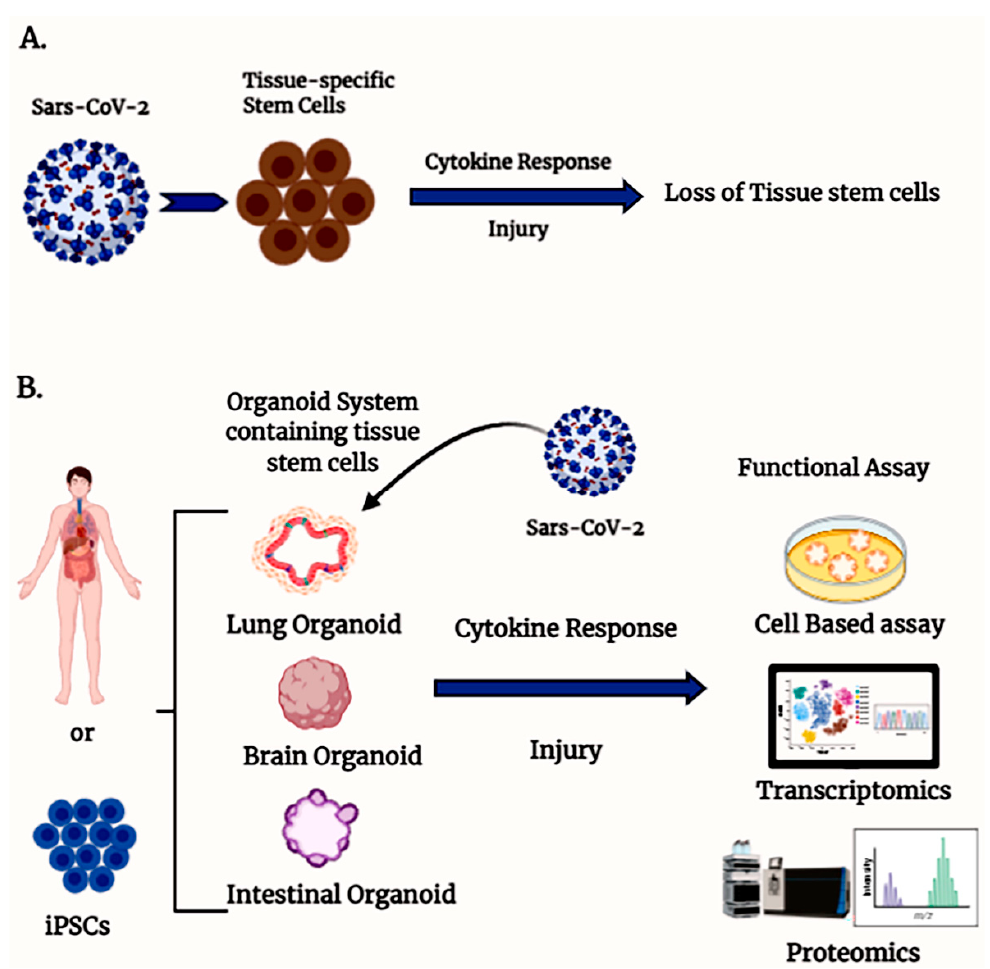
Figure 1. Organoids containing tissue stem cells are an ex vivo model to study severe acute respiratory syndrome coronavirus type 2 (SARS-CoV-2) infection. ( A ) Schematic diagram illustrating the involvement of SARS-CoV-2-mediated stem cell loss. ( B ) Different organ-specific stem cell-derived organoid models to study SARS-CoV-2 infection.